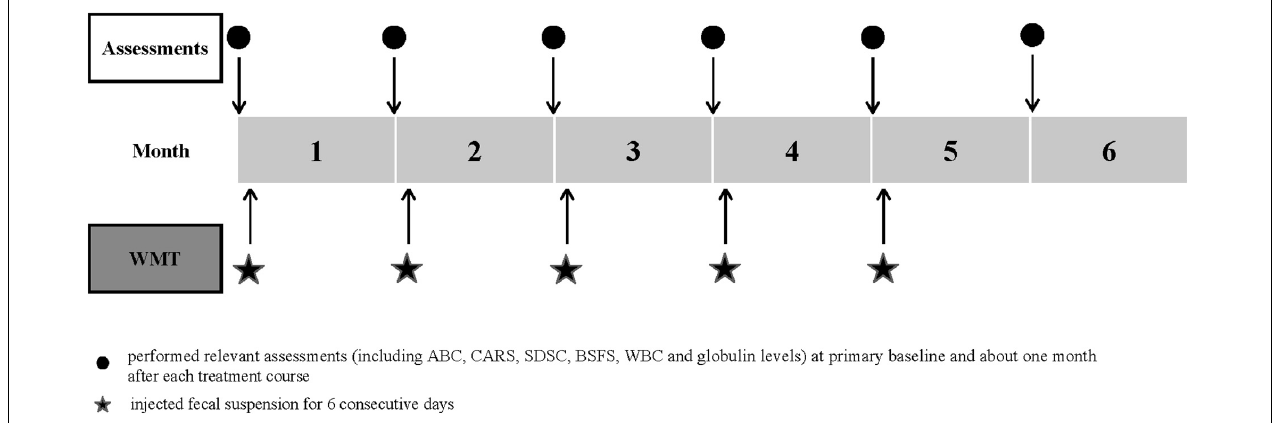
FIGURE 1 | Study design timeline. The time schedule of relevant assessments and treatment courses. ABC, Aberrant Behavior Checklist; BSFS, Bristol Stool Form Scale; CARS, Childhood Autism Rating Scale; SDSC, Sleep Disturbance Scale for Children; WBC, white blood cell; WMT, washed microbiota transplantation.